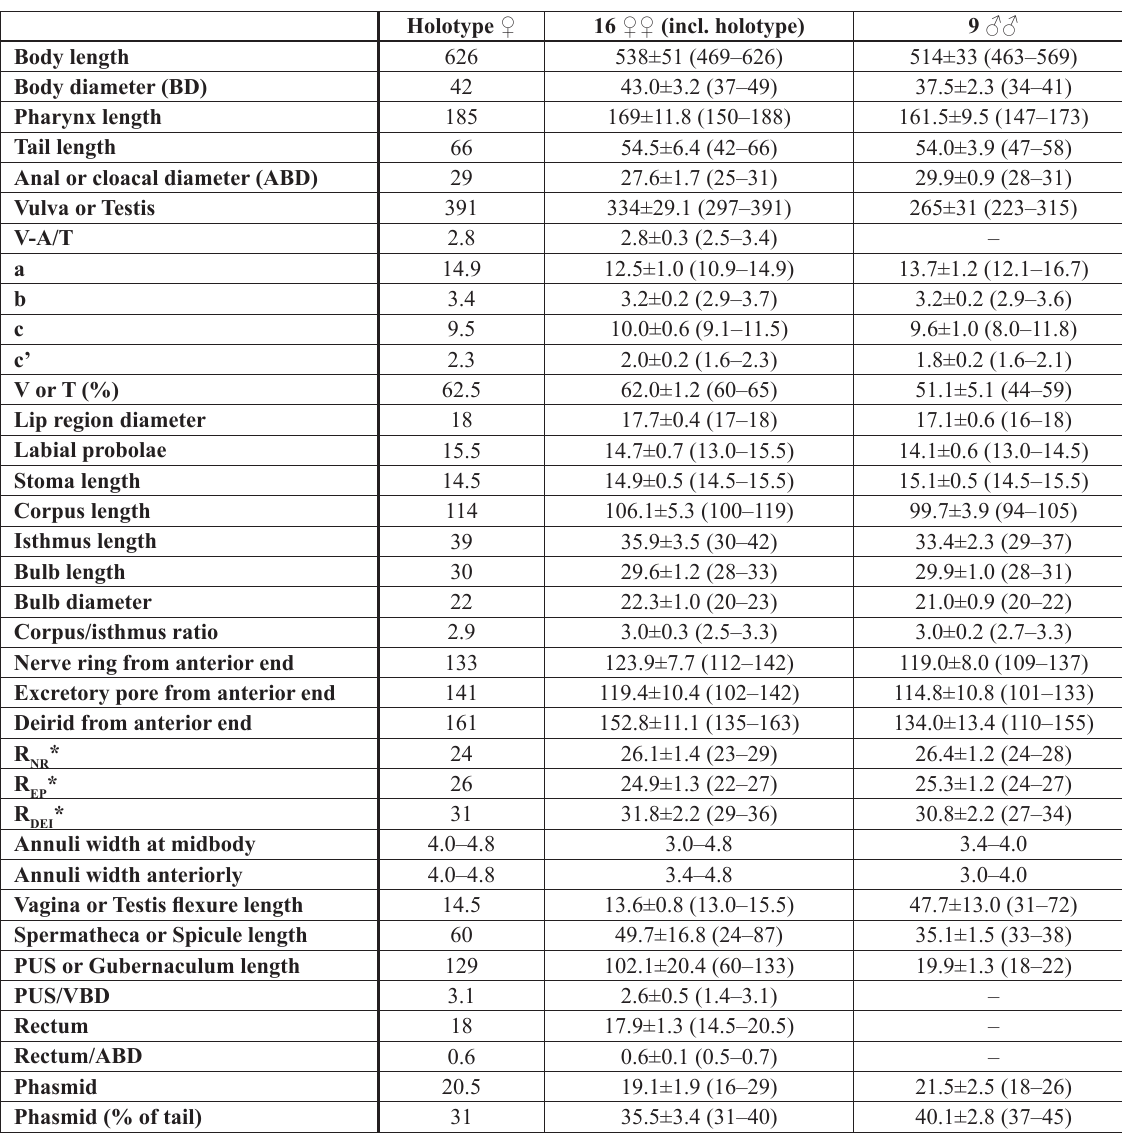
Table 1. Measurements (in µm) of Paracrobeles kelsodunensis sp. nov. from Kelso Dunes, Mojave Desert, California (presented as mean±s.d. and (range) or only range). * Number of annuli from anterior end to nerve ring, excretory pore and deirid, respectively; – indicates that data is not applicable. Holotype